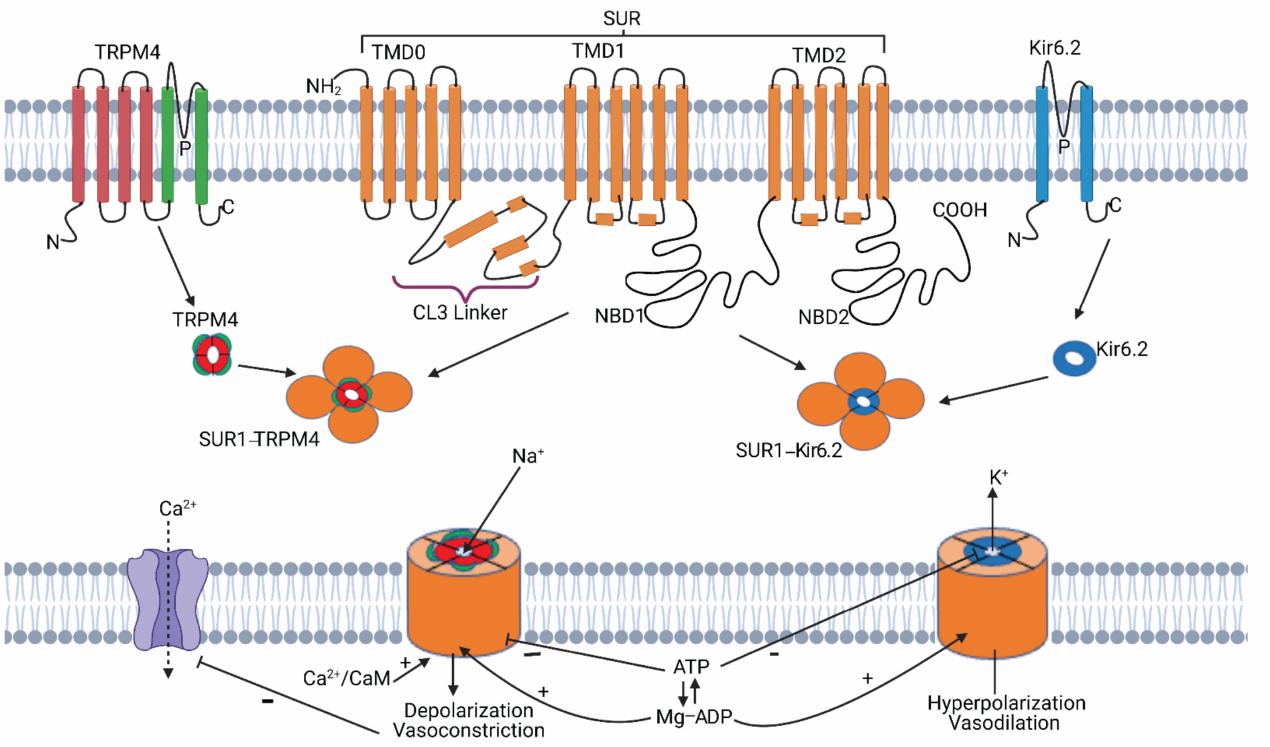
Figure 1. Schematic depiction of SUR1, TRPM4, and Kir6.2 topology. TRPM4 monomers consist of six transmembrane helices with a pore region (P). SUR1 is composed of two interacting six-helix trans-membrane domains (TMD1 and TMD2), each containing a nucleotide binding domain NBD1 and NBD2. TMD0 interacts directly with Kir6.2. Four TRPM4 subunits oligomerize with four SUR1 subunits to form the functional SUR1-TRPM4 octameric channel. Influx of Na + via the nonselective monovalent cation pore-forming subunit TRPM4 leads to depolarization. Figure created with BioRender.com